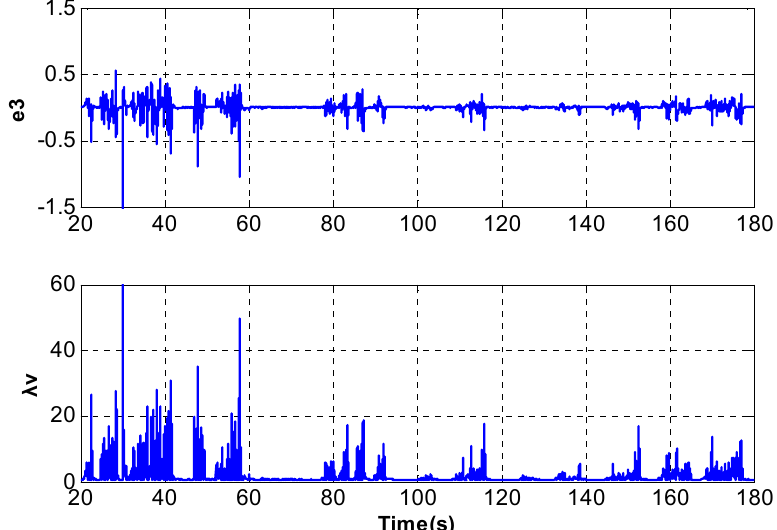
Figure 17. Fuzzy input 3 e and fuzzy output v λ during flight .